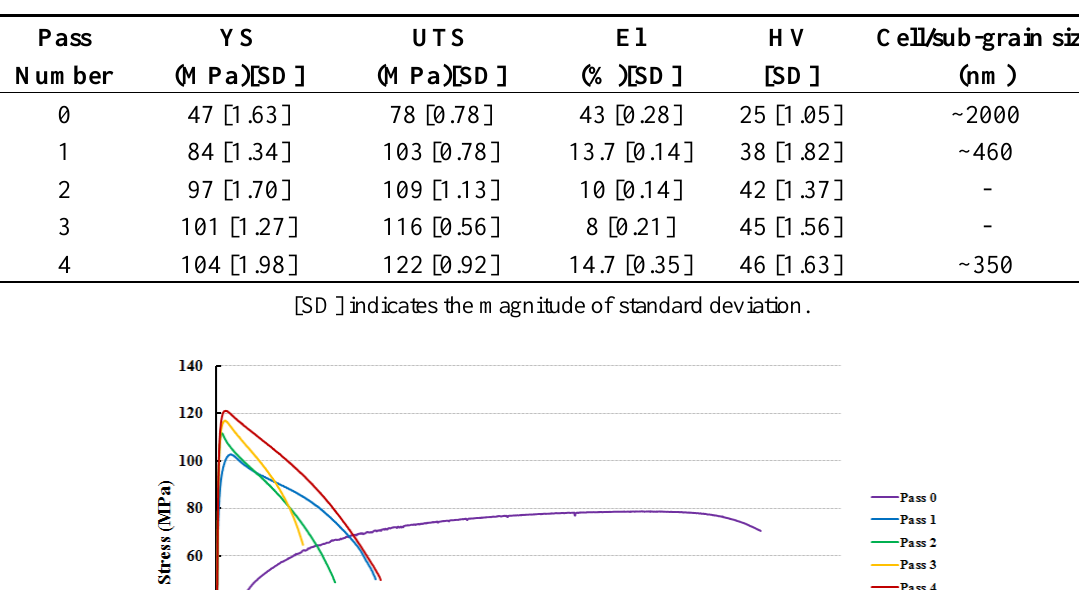
Table 1. The mechanical properties and grain size of CP aluminum billets before and after the ECFE process up to four passes.